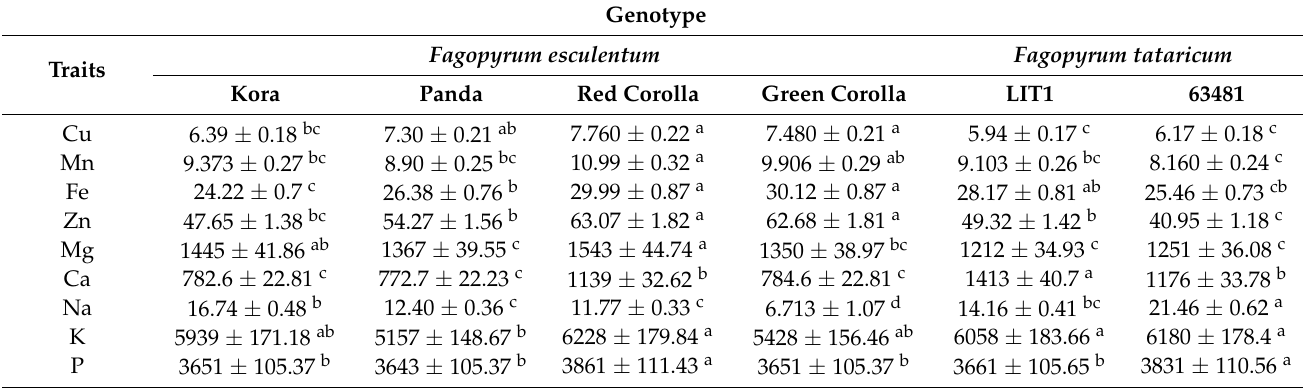
Table 2. The mineral content of buckwheat genotypes (mg · kg − 1